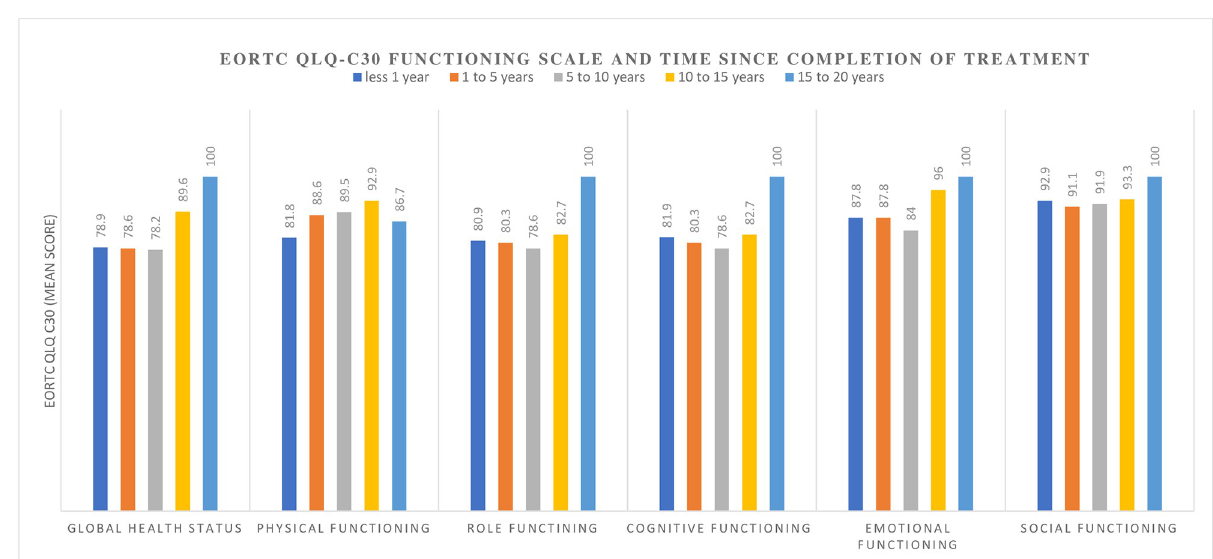
Fig 2. The change in EORTC QLQ C30 functioning scores of cervical cancer survivors after treatment at Komfo Anokye Teaching Hospital, Kumasi, Ghana.